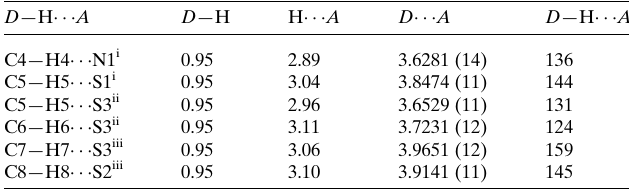
Table 1 Hydrogen-bond geometry (A˚ , (cid:2) ).